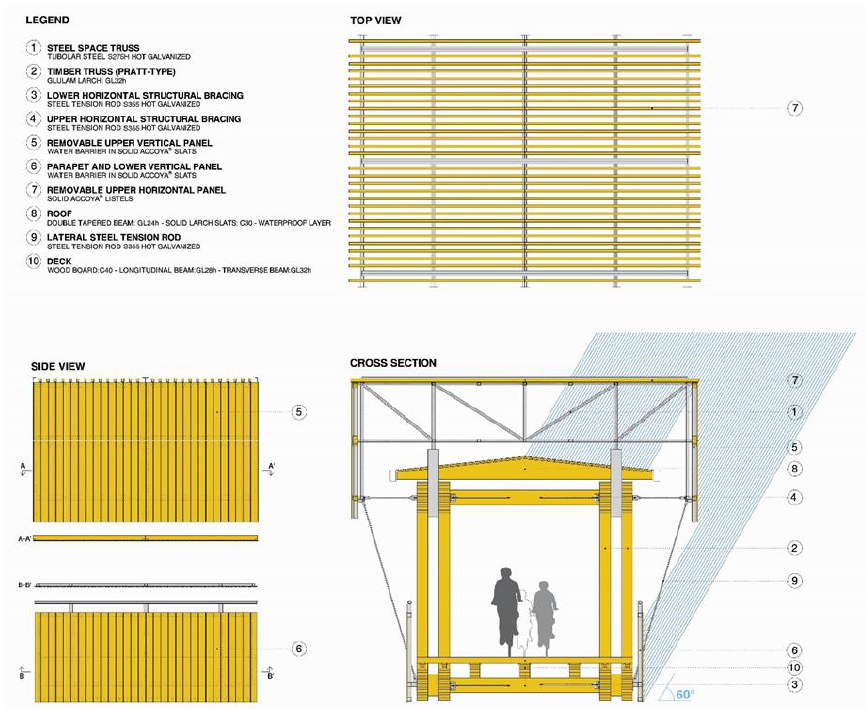
Figure 6. Design for durability of the timber bridge.